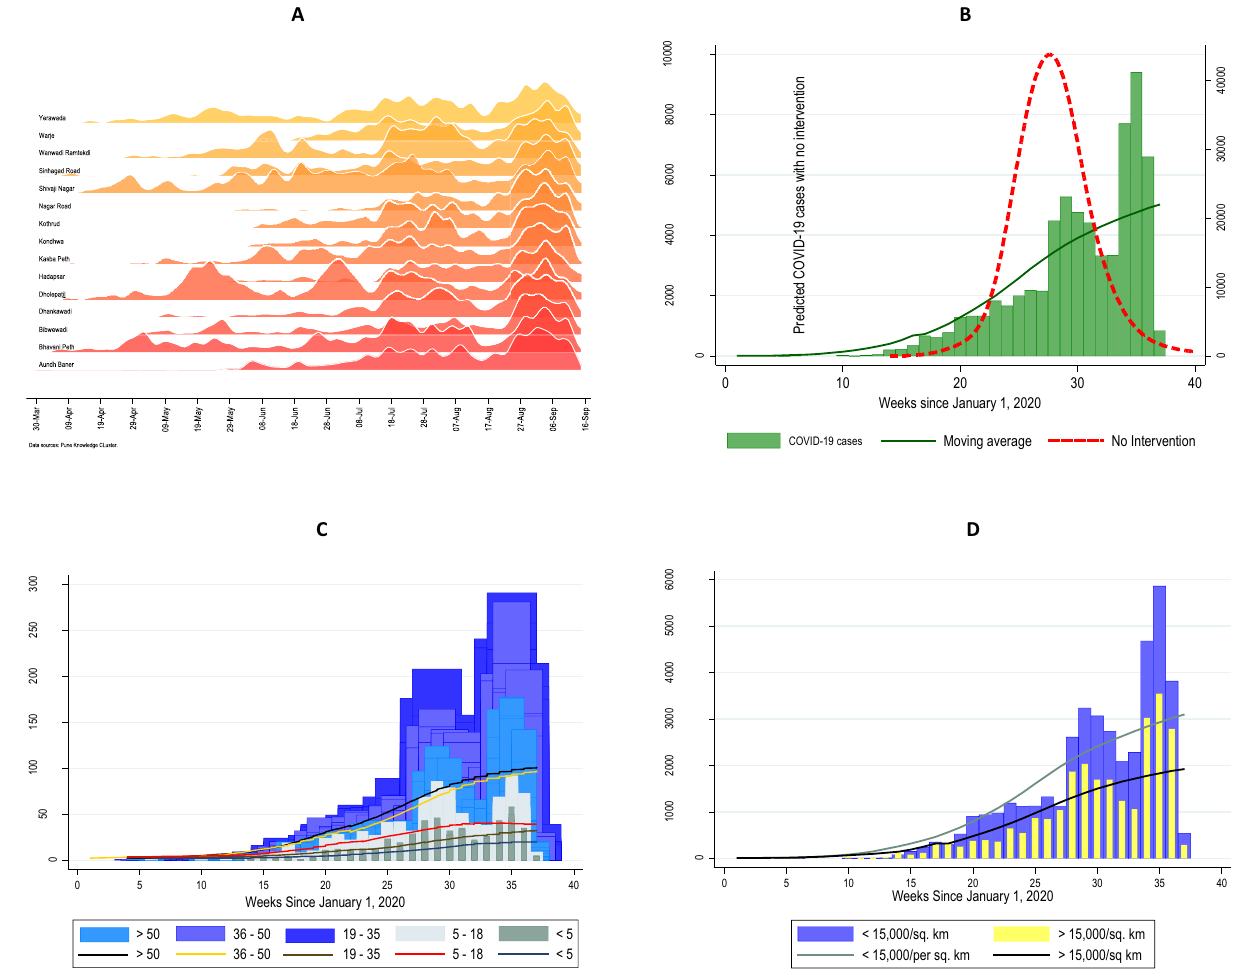
Figure 2. Shows the trajectory of new COVID-19 patients within Pune Municipal Corporation (PMC) over time. Lockdown/unlock periods defined as: pre-lockdown (1st February–24th March 2020); nationwide COVID-19 patients across Pune Municipal Corporation ward offices during the study period. ( B ) Weekly incident COVID-19 patients by natural epidemic, and lockdown status in the overall patients. The red broken line represents projection modelling of the natural epidemic considering R 0 =1.8; green line represents overall patients. ( C ) Weekly incidence of COVID-19 by age groups. ( D ) Weekly incident COVID-19 patients by population